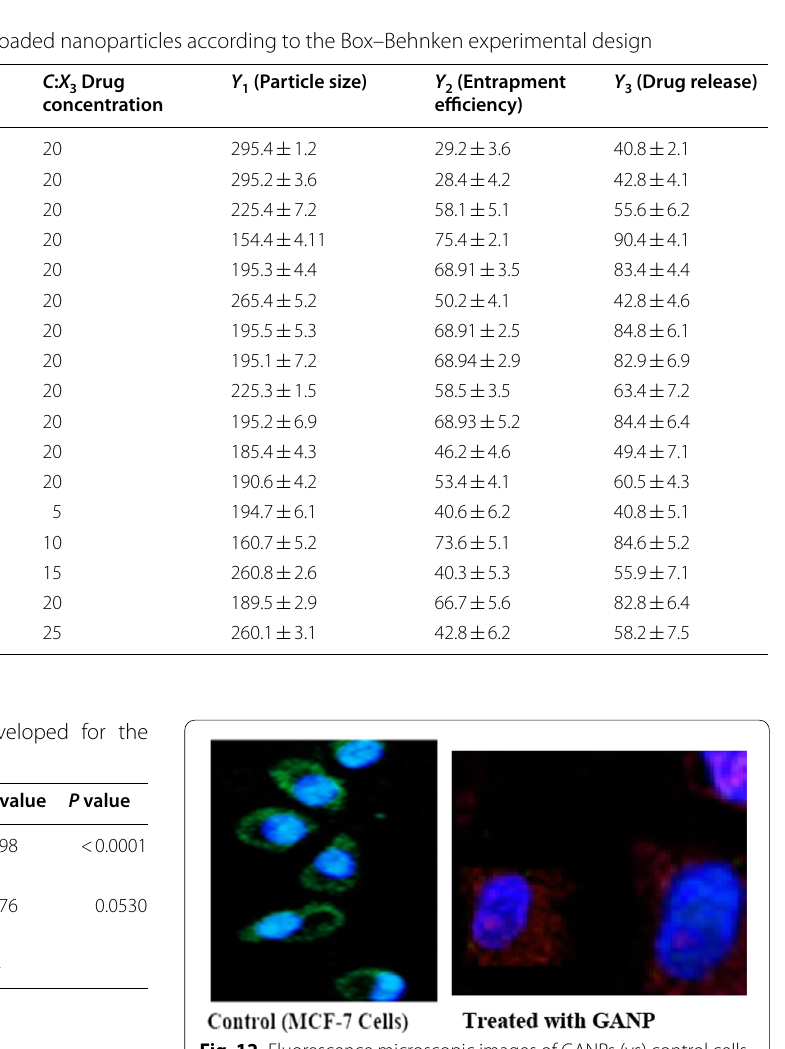
Fig. 12 Fluorescence microscopic images of GANPs (vs) control